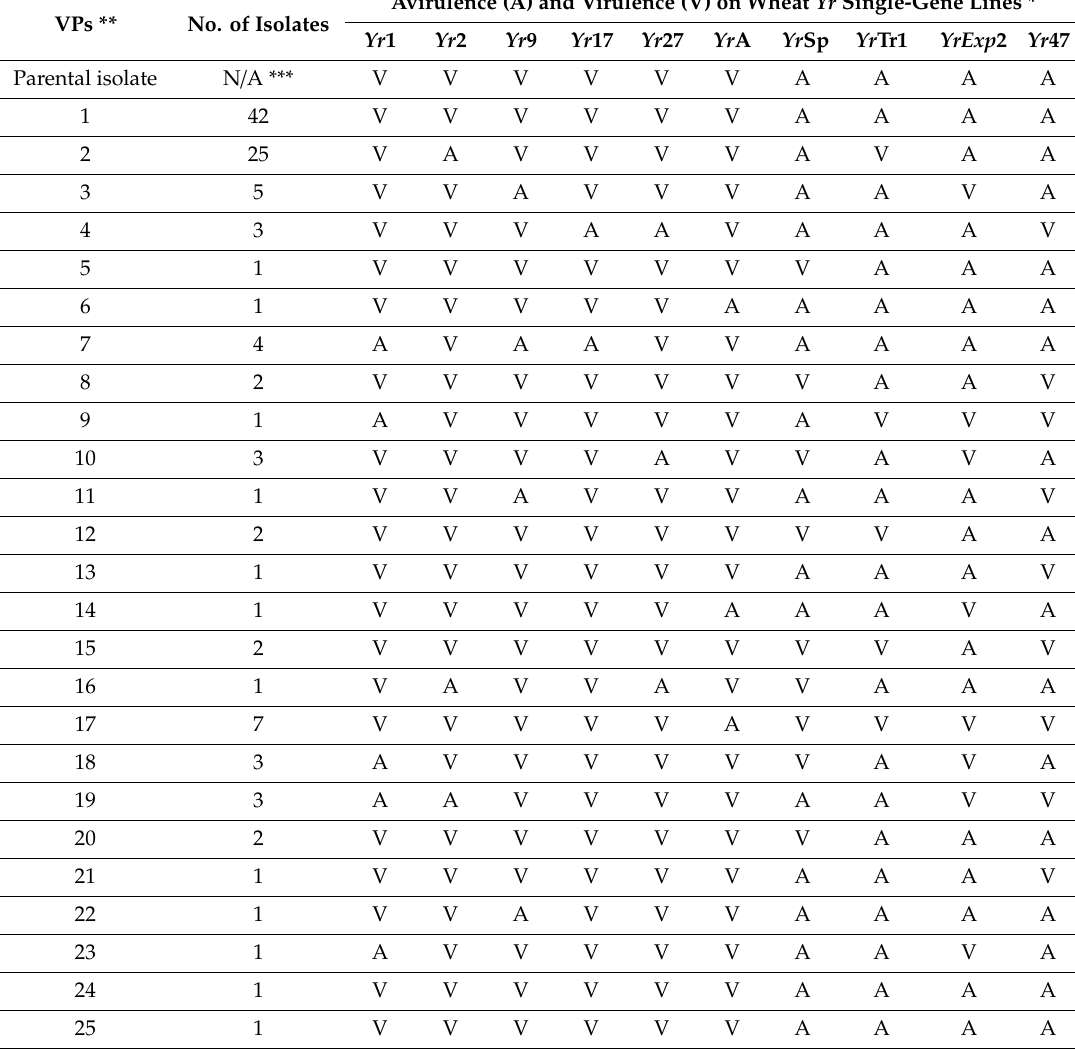
Table 1. Virulence phenotypes (VPs) of the parental and one hundred and fifteen progeny isolates of Pakistani dominant race (574232) of Puccinia striiformis f. sp. tritici ( PST ) on 24 wheat Yr single-gene